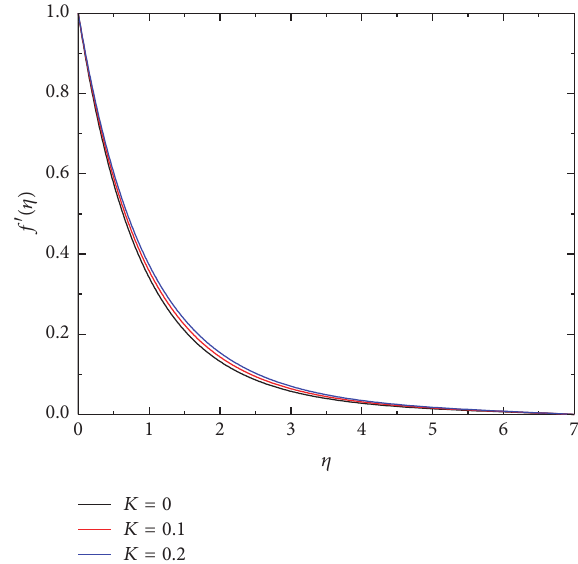
the parameters are considered as 𝜆 0 = 0.3, 𝐵 = 0.1, Pr = 0.72, Ec = 0.05 , and 𝐻 = 0 unless otherwise specified.